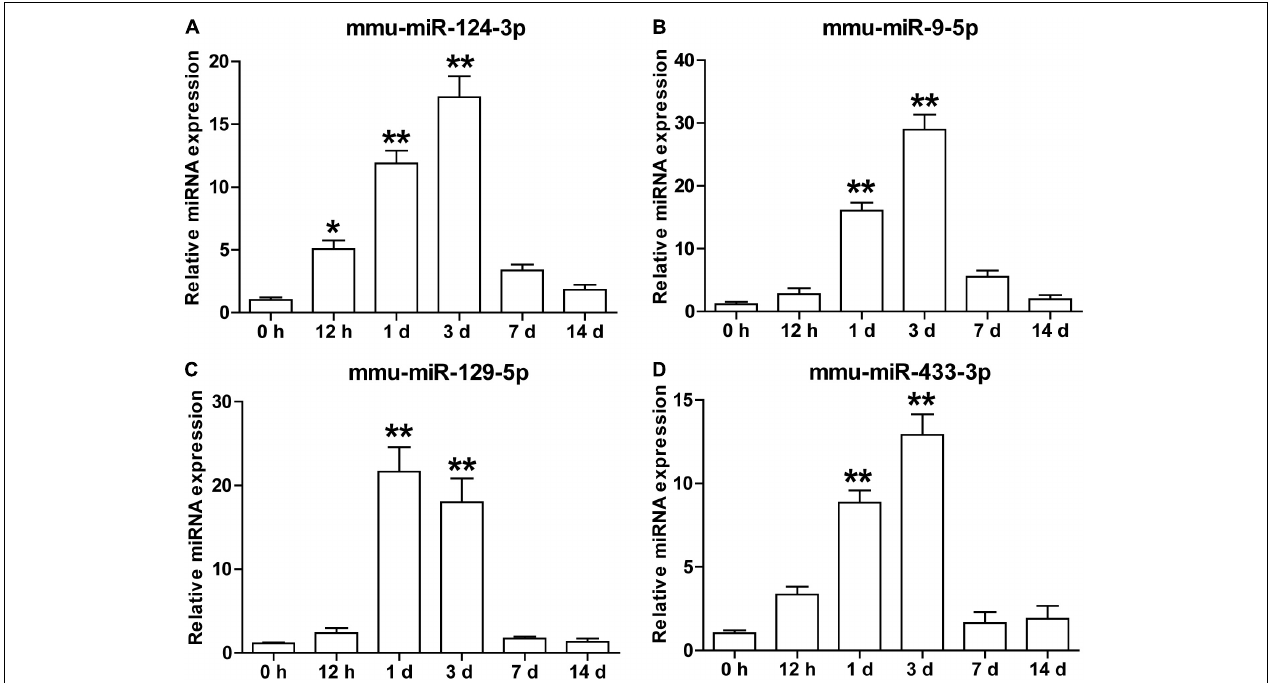
FIGURE 6 | The temporal expression of brain-specific miRNAs in the serum sEVs from the tMCAO mouse model. The levels of mmu-miR-124-3p (A) , mmu-miR-9-5p (B) , mmu-miR-129-5p (C) , and mmu-miR-433-3p (D) in mouse serum sEVs were detected by qRT-PCR at 0.5, 1, 3, 7, and 14 days after the onset of ischemia. The Ct value was normalized against mmu-miR-451. Each time point represents the mean of 3 pooled serum samples (4–6 animals per sample). Data were presented as Mean ± SEM. Statistical significance was determined by non-parametric one-way ANOVA followed by Dunn’s post-test, * p < 0.05, ** p < 0.01 vs. sham control (0